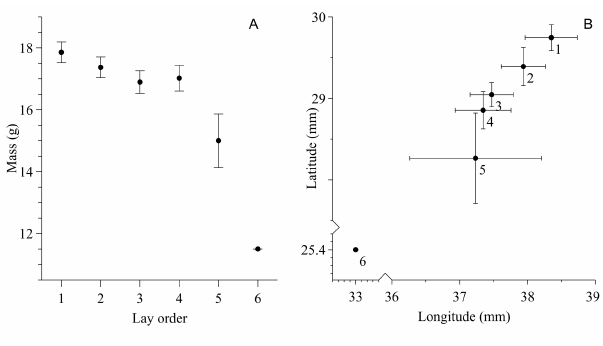
Fig. 3 . Means (dots) and SE (lines) of mass (A) and maximum longitude and latitude (B) of Turquoise-fronted Parrot ( Amazona aestiva ) eggs at Loro Hablador Provincial Park in northern Argentina. Ns are the sample sizes of measured eggs according to their laying order: first egg N1 = 30; second egg N2 = 32; third egg N3 = 29; fourth egg N4 = 21; fifth egg N5 = 3; and sixth egg N6 = 1).